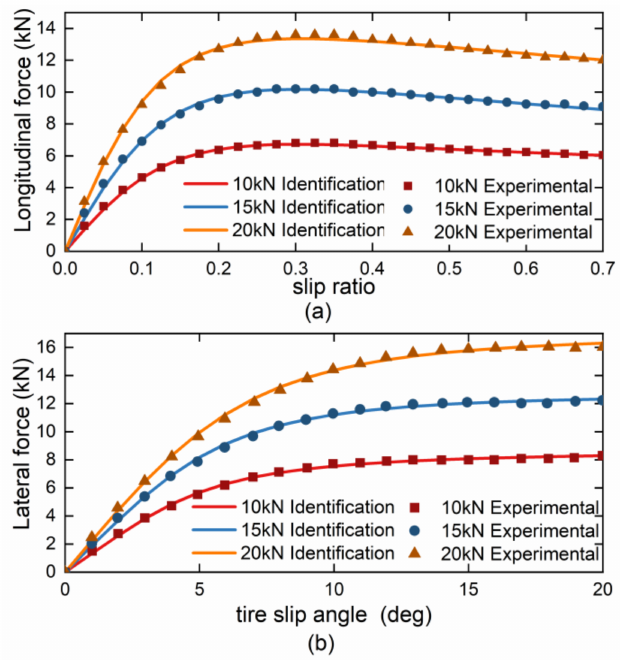
Figure 2. Tire model identification results. ( a ) Longitudinal force recognition results. ( b ) Lateral force recognition